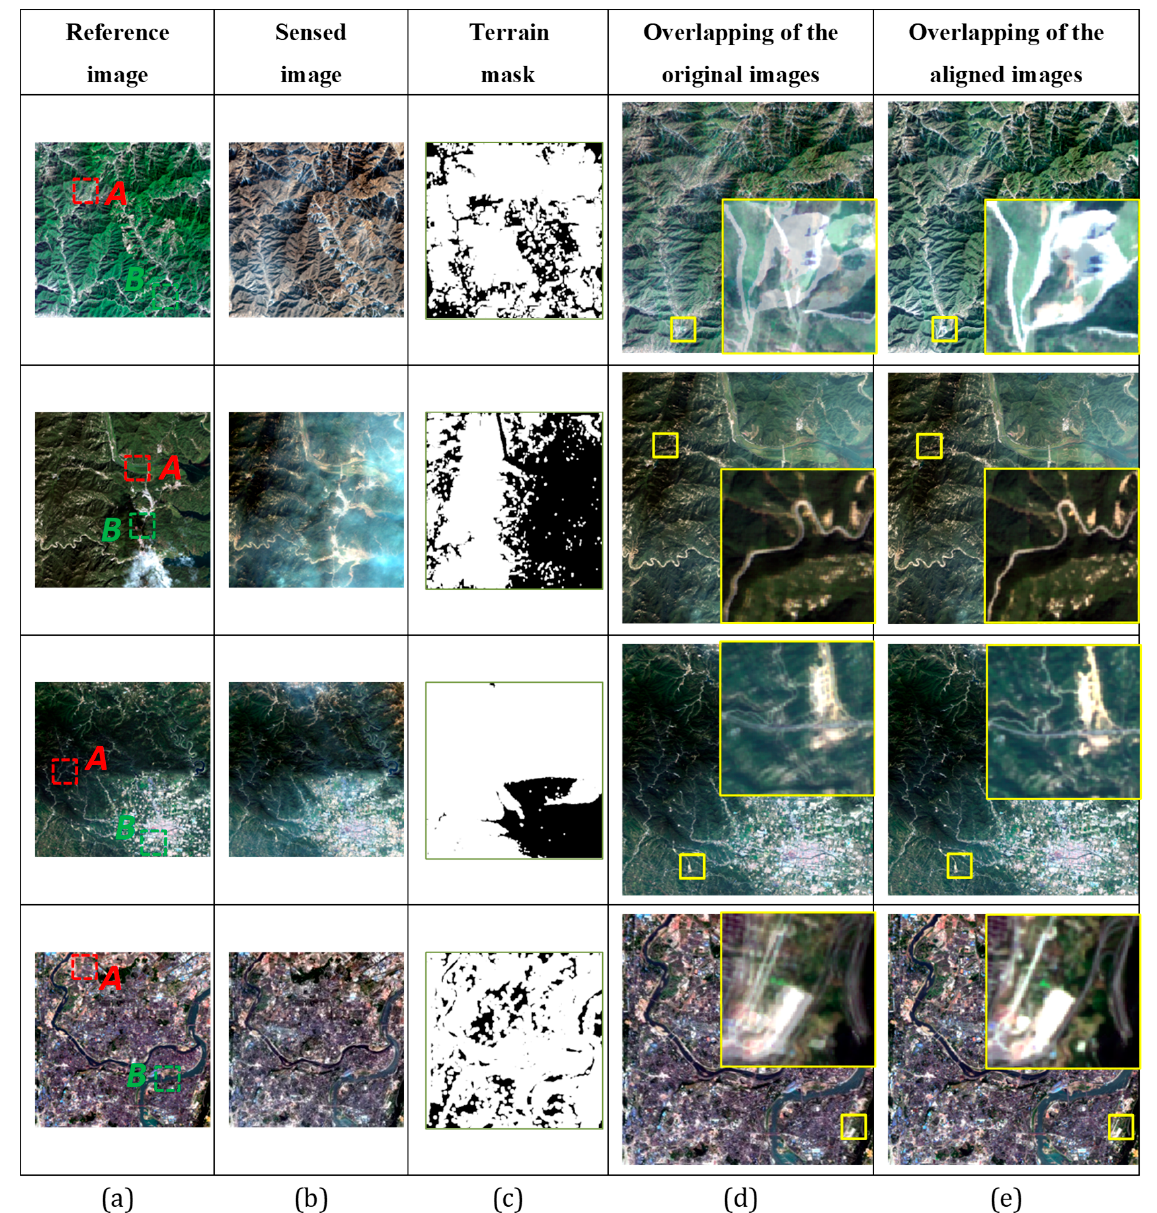
Figure 6. The registration results of the proposed method. From top to the bottom they correspond to test-I, test-II, test-III, and test-IV, respectively. ( a ) Reference image, ( b ) sensed image, ( c ) terrain mask (white means the complex-terrain region, otherwise are flat-terrain regions) the overlapping result of reference and ( d ) the sensed image, ( e ) the aligned image. Successively, the comparison results of the proposed algorithm and other comparative methods are shown in Figure 7, which are the enlarged sub-regions of the red and green dotted-rectangle regions in Figure 6a for fine comparisons. The vertical alignment is labeled with red “ A ” and the horizontal alignment is marked with green “ B ”. The boundaries of the reference and aligned images are available to judge the registration accuracy. The white arrows and filled circles are auxiliary to indicate the displacements between the reference and aligned image. The arrows depict the direction of misalignment and their lengths are proportional to the amount of dislocation from the aligned image to the reference image. The white filled circles represent the well-registered